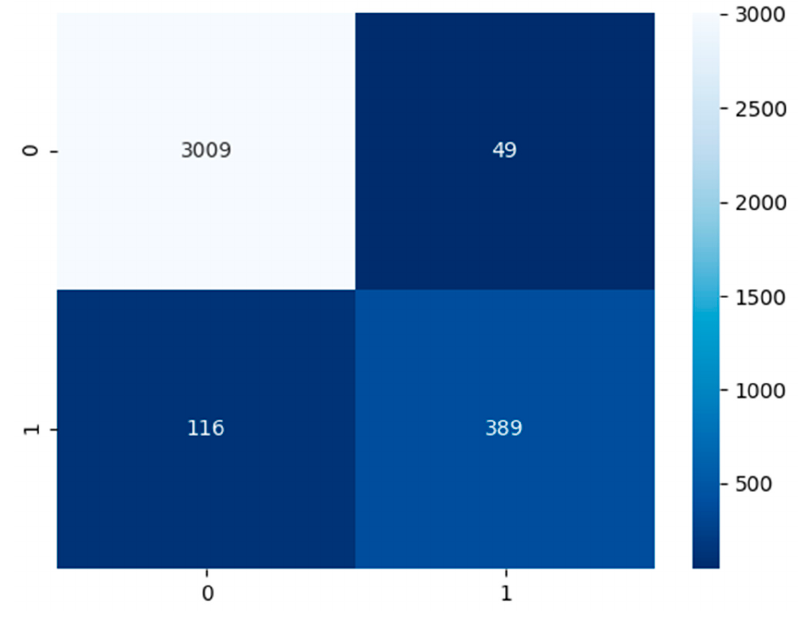
Figure 6. Figure 6. COVID-19 CXR Model Confusion Matrix.